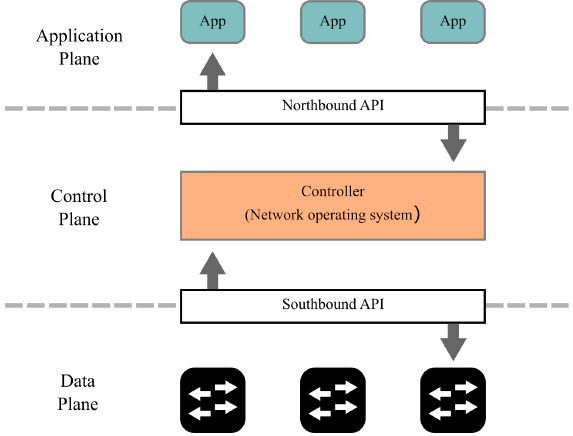
Figure 1. The general architecture of